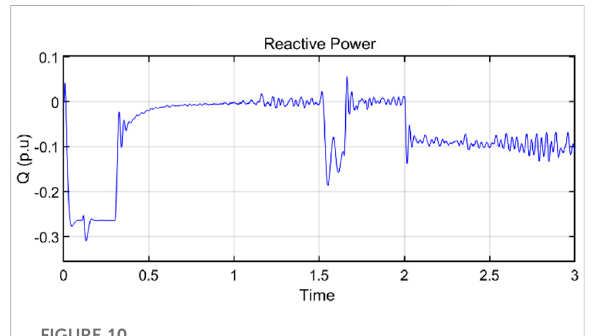
FIGURE 10 Reactive Power Curve for a simple PI Controller.